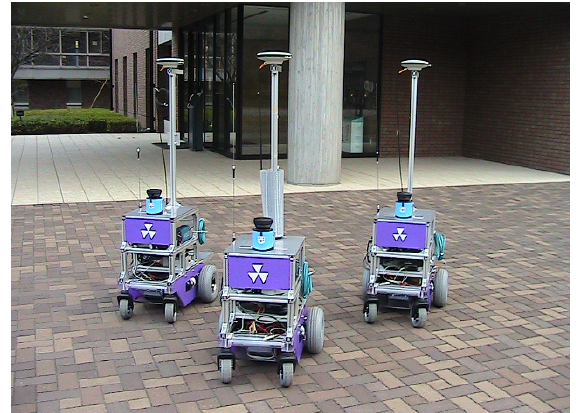
Figure 2. Overview of the mobile robot